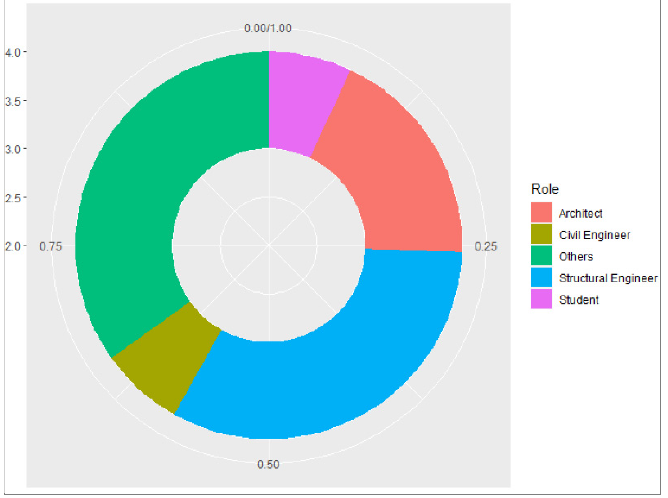
Figure 1. Roles of the participants in the industry.